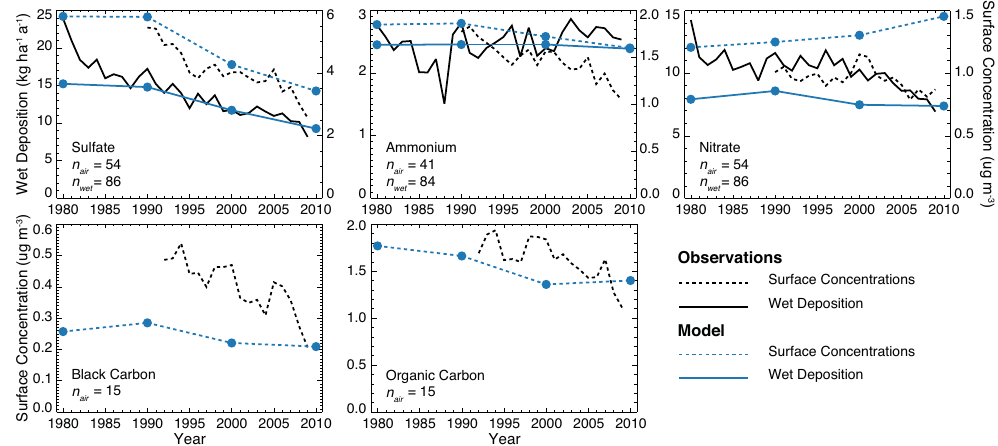
Fig. 3. 1980–2010 trends in wet deposition fluxes (solid) and surface aerosol concentrations (dashed) in the eastern US (east of 100 ◦ W). Values are annual means. Model trends (blue) are compared to observations (black). The number of sites averaged in each calculated trend is given inset. Model values are sampled at the site locations and then averaged.